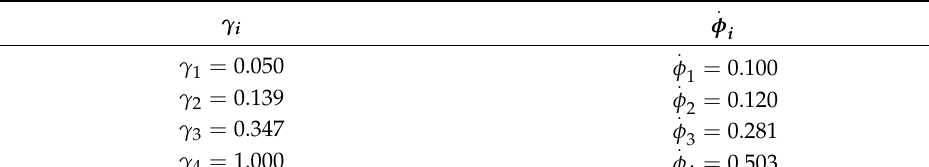
Figure 3a–c are the time-domain curves of the ship roll angular displacement with wave height of 0.5 m, 1.5 m and 2.5 m. In the simulation calculation, the gyrostabilizer was set to be put into operation in the time range of 100 s to 200 s.